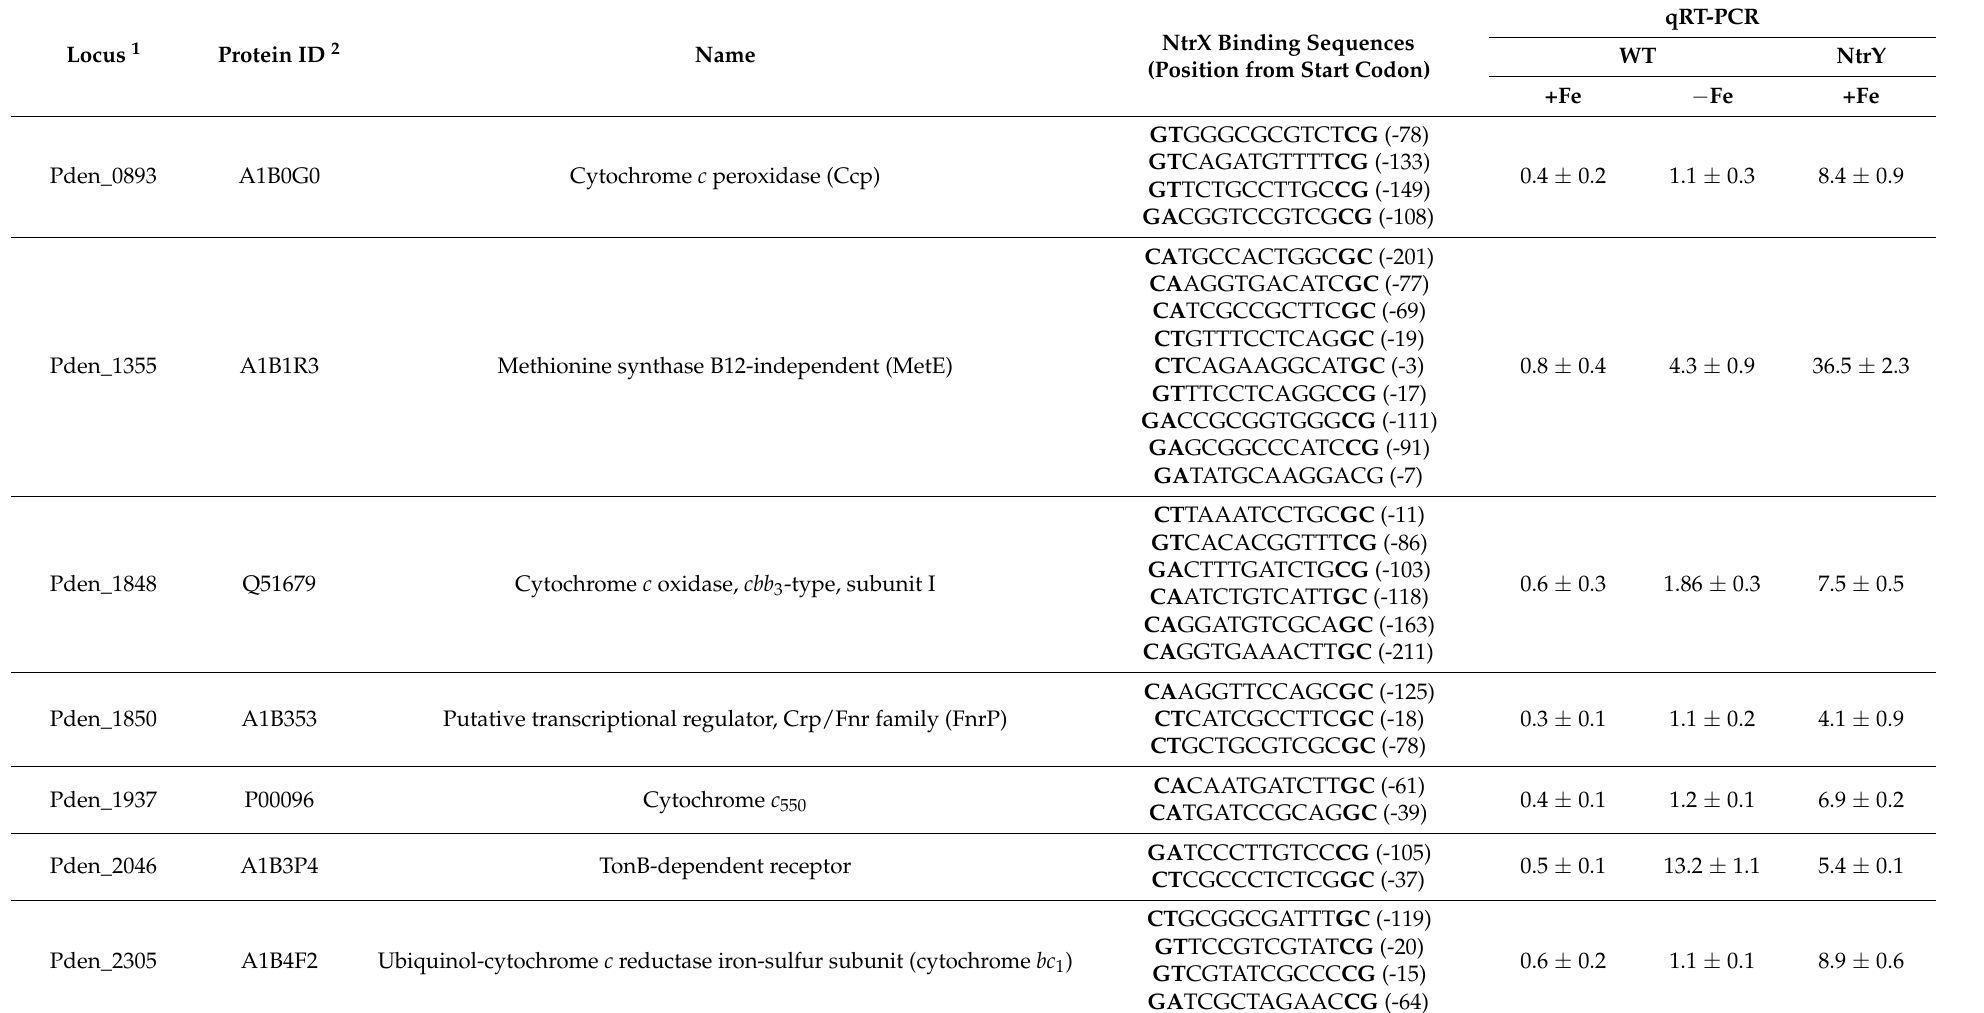
Table 2. Transcriptional analysis by qRT-PCR of putative NtrX target genes of P. denitrificans